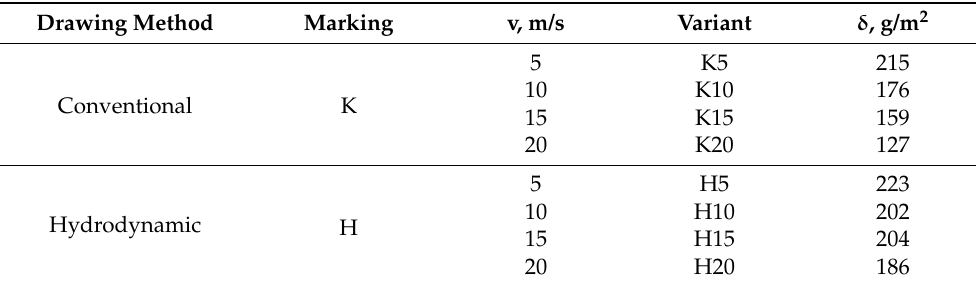
Table 2. Marking of technological variants of wires with zinc coatings, where v is the drawing speed and δ is the the zinc mass on the ϕ 2.2 mm wire